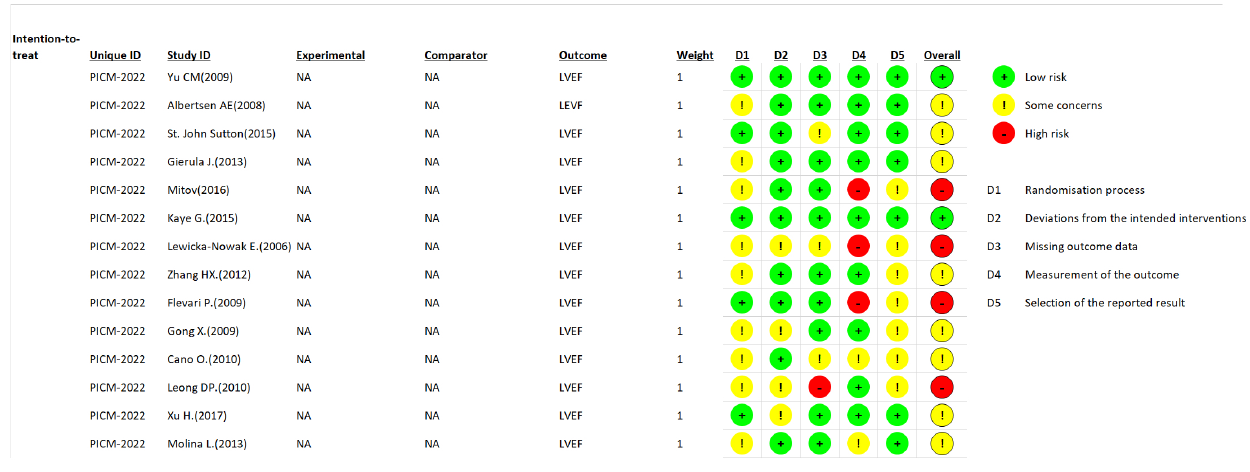
Figure 2. Risk of bias summary for the included studies. Green indicates low risk of bias. Red indicates high risk of bias. Yellow indicates some concerns